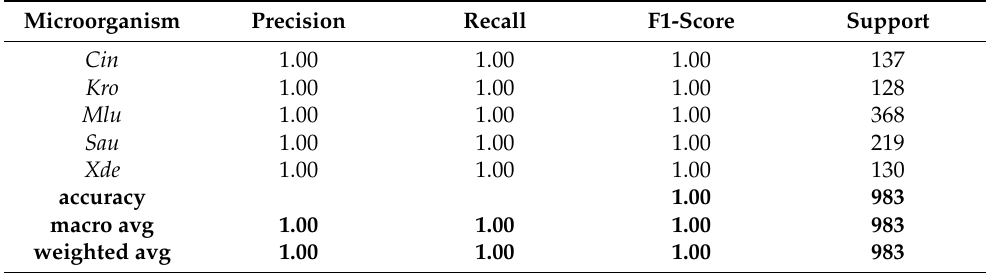
Table 4. Precision, recall, F1 score and support with model 1 for carotenoid-containing microorganisms. Microorganism